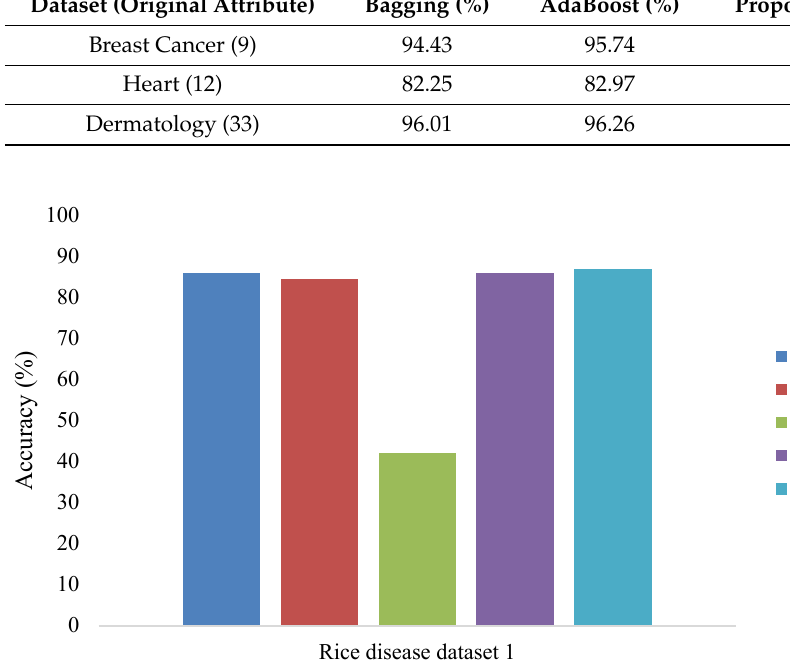
Figure 6. Accuracy for Rice disease dataset1 in the big data environment.